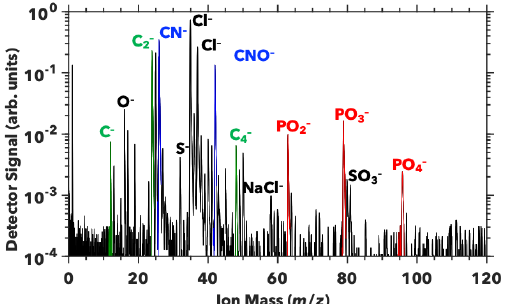
Figure 2. SSA mass spectrum. A representative mass spectrum from PALMS (Pacific Microlayer Sample 2) shows indicators of carbon, organic nitrogen, and phosphorus molecules that may en- hance ice nucleation activity of SSA (Wolf et al., 2019). Carbon peaks are labeled in green, organic nitrogen in blue, and phospho- rus in red. Inorganic peaks are labeled in black.